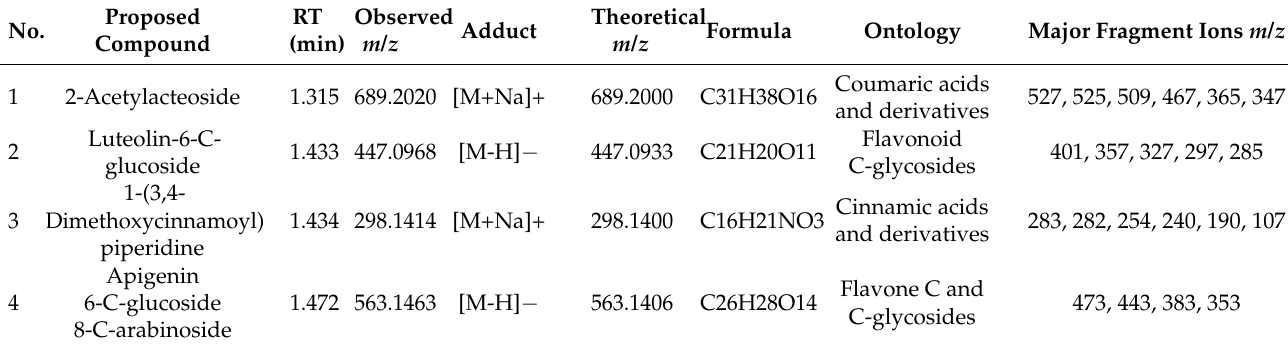
Table 1. The information of compounds identified in